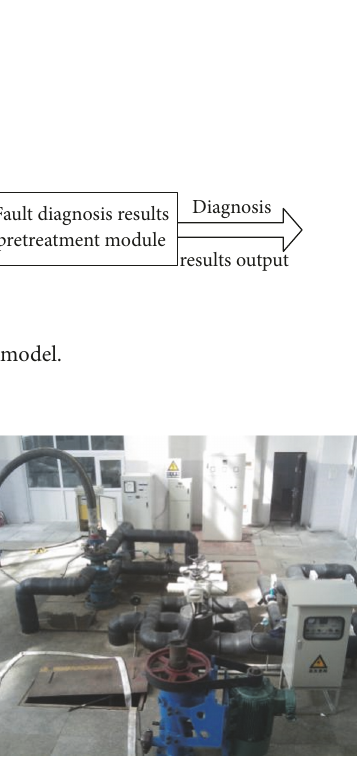
Figure 7: Experimental platform.